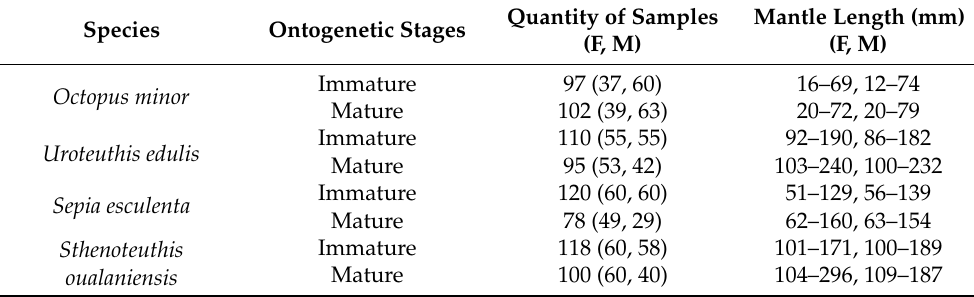
Table 1. Sample information of four cephalopods in this